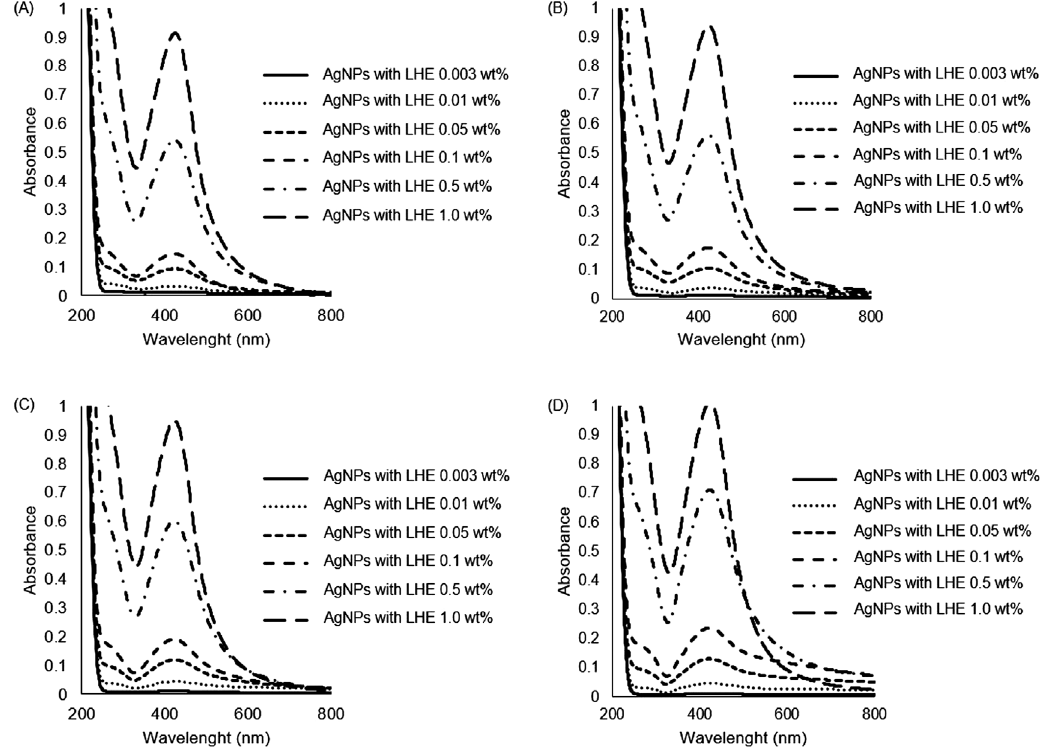
Figure 5: (a) to (d) represent UV-Vis spectra of different AgNPs colloidal solutions reduced and stabilized with LHE measured at: (a) week 2, (b) week 3, (c) week 4 and (d) week